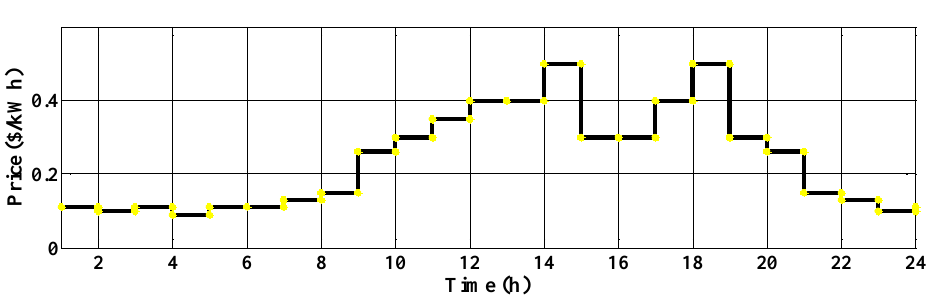
Figure 5. The hourly wind speeds.